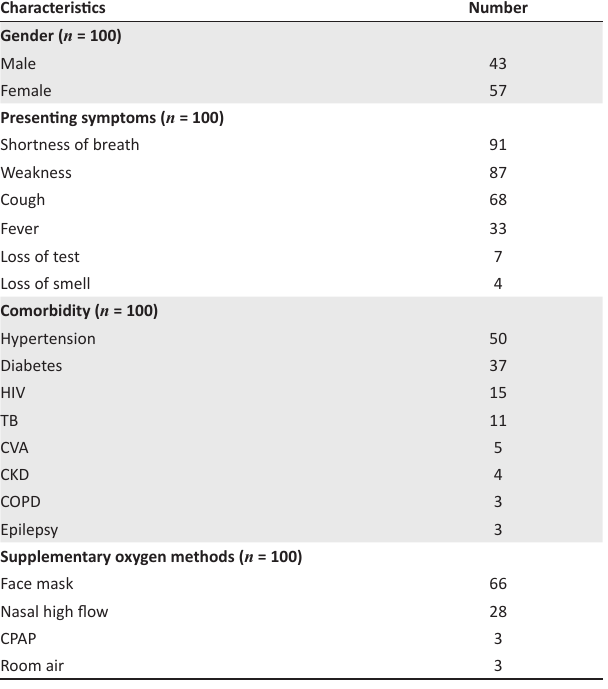
TABLE 1: Clinical characteristics of the hospitalised patient who died due to COVID-19. Characteristics